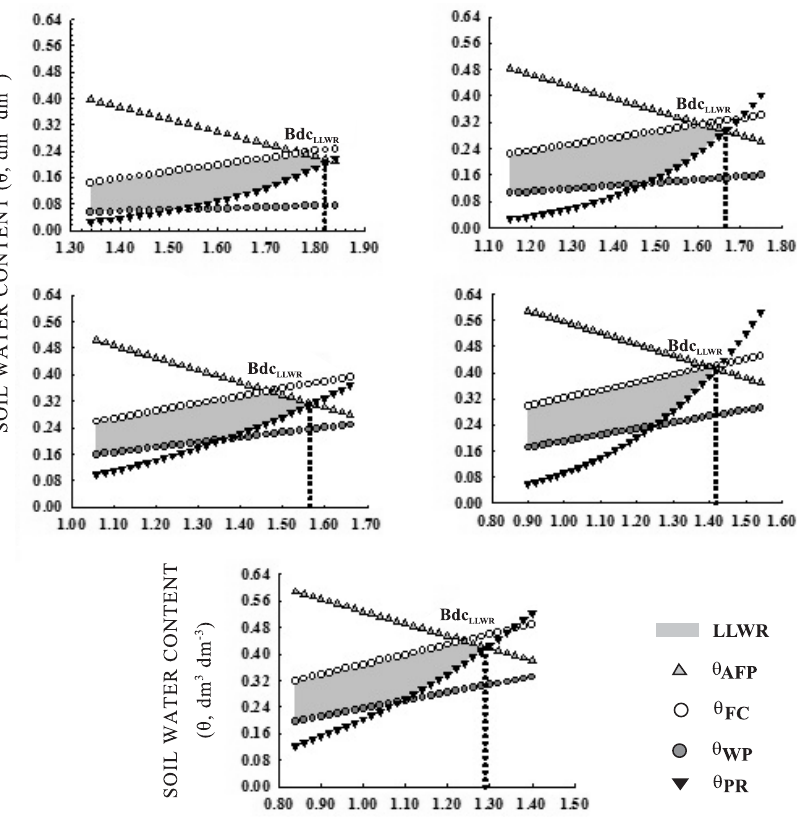
Figure 1. Variation in soil water content ( θθθθθ ) with the increase in bulk density (Bd) in the critical limits of field capacity ( θθθθθ , -6 kPa), permanent wilting point ( θθθθθ , -1,500 kPa), aeration porosity of 10 % ( θθθθθ FC WP and soil penetration resistance 2.5 MPa ( θθθθθ ), of Latosols (L) in the county of Rio Verde. Gray areas PR represent the least limiting water range (LLWR); Bdc : critical density for plant development, LLWR corresponding to LLWR. Subscripts in the abbreviation of Latosols indicate clay contents (g kg -1